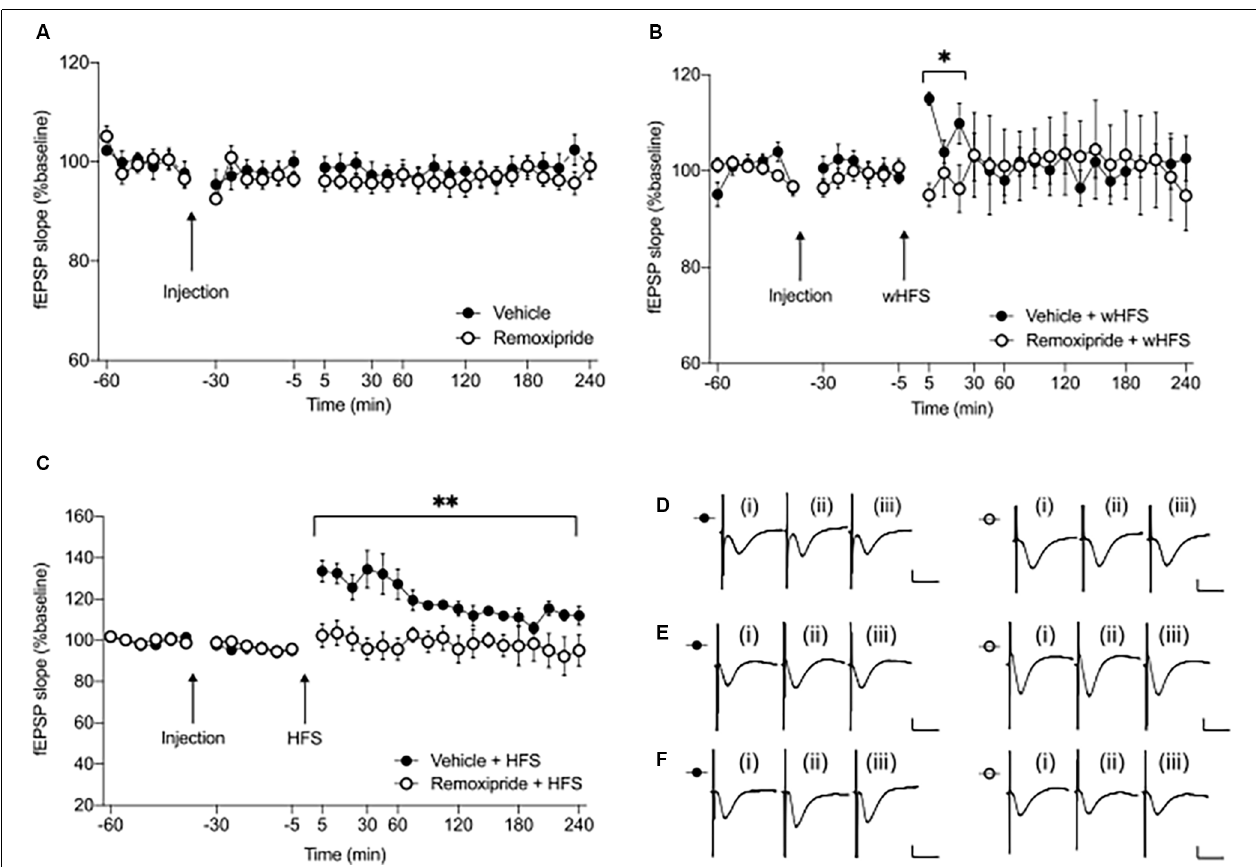
FIGURE 1 | Pharmacological antagonism of D2-like receptors (D2R) prevents initiation of short and long-term synaptic potentiation at CA3-CA1 synapses. (A) The dopamine D2R antagonist remoxipride (50 µ g, icv) does not alter basal synaptic transmission in freely behaving rats ( n = 7, p = 0.40). (B) Application of weak high frequency stimulation (wHFS), in the presence of the D2-like receptor antagonist, remoxipride, prevents STP ( n = 7, ∗ p < 0.05). (C) Similarly, high frequency stimulation (HFS) in the presence of remoxipride inhibits LTP ( n = 6, ∗∗ p < 0.01). Arrows indicate time-points of injection or wHFS/HFS stimulation. Filled circles represent control experiments conducted in vehicle treated animals, while open circles indicate experiments where drug was applied prior to stimulation. Values represent ± SEM. (D–F) Analog responses recorded during remoxipride baseline experiments (D) , wHFS (E) or high frequency stimulation experiments (F) . In each case (i) shows an fEPSP evoked in the first 30 min of recordings; (ii) shows an fEPSP evoked at the 5 min time-point; and (iii) represents an fEPSP recorded at the 240 min timepoint; filled circles—vehicle treatment, open circles—remoxipride injection. Scale bars represent: 1 mV vertical/10 ms